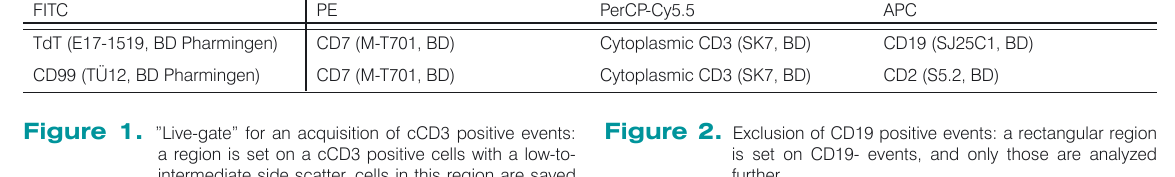
Table 1. Marker panel for T-ALL MRD detection.